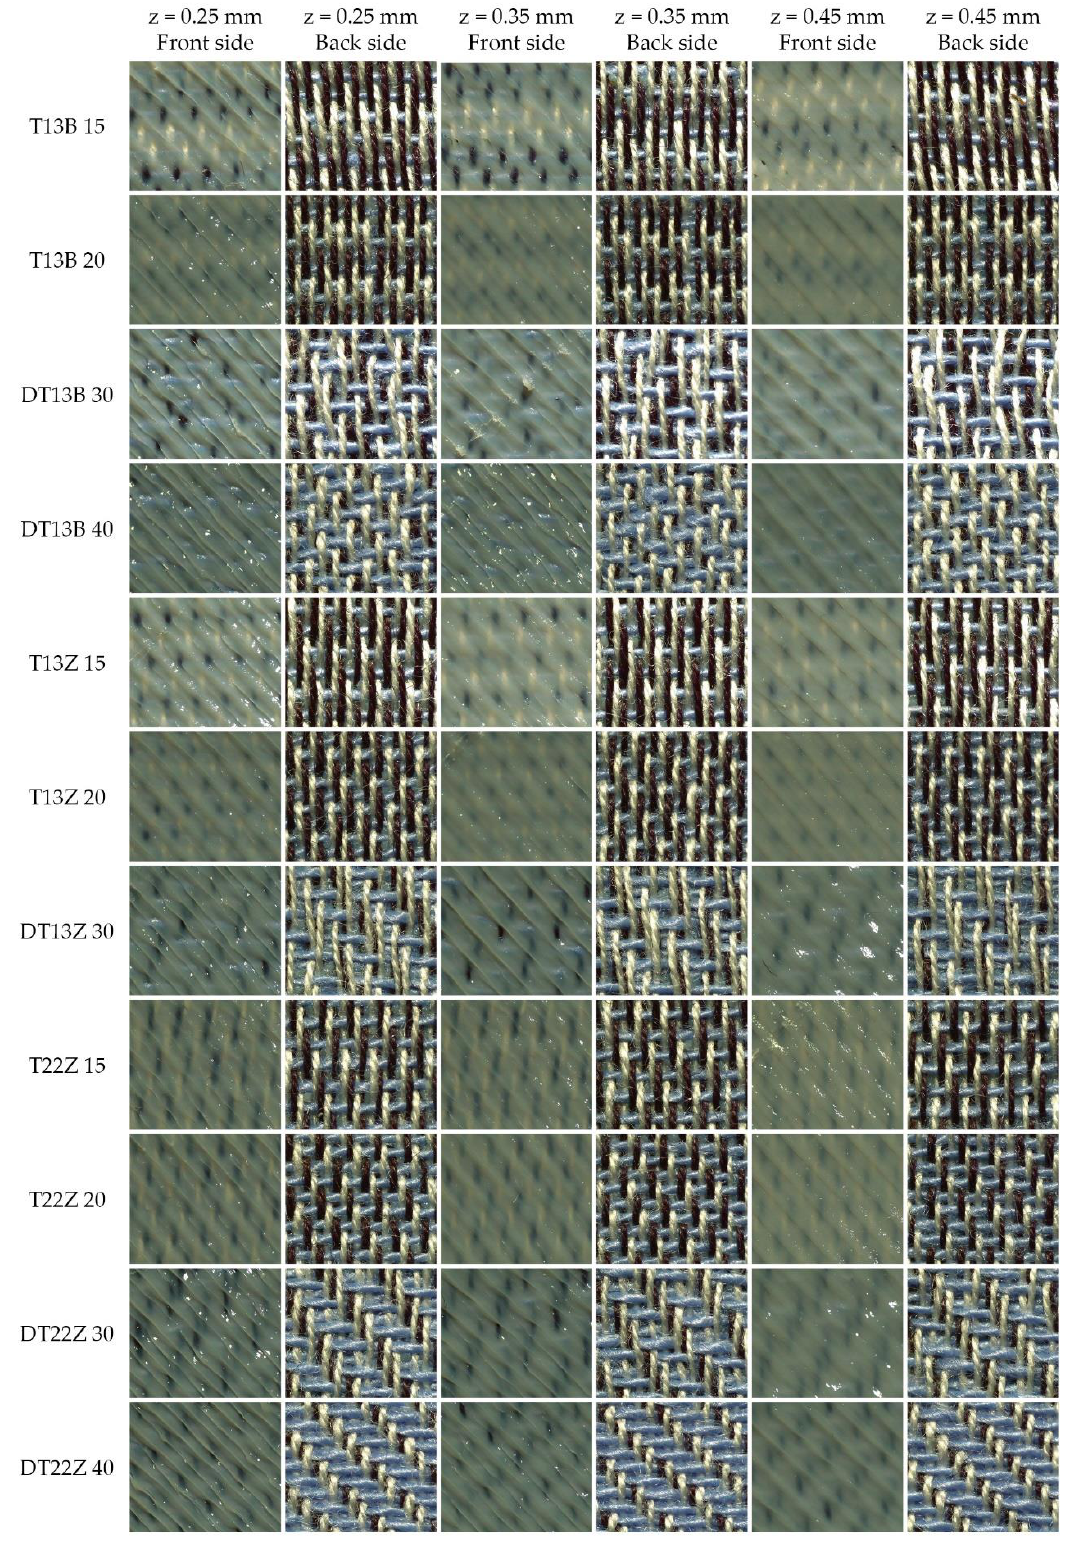
Figure A2. Front and back sides of the three-dimensional printed samples at different constant z-distances (mag. 20×).